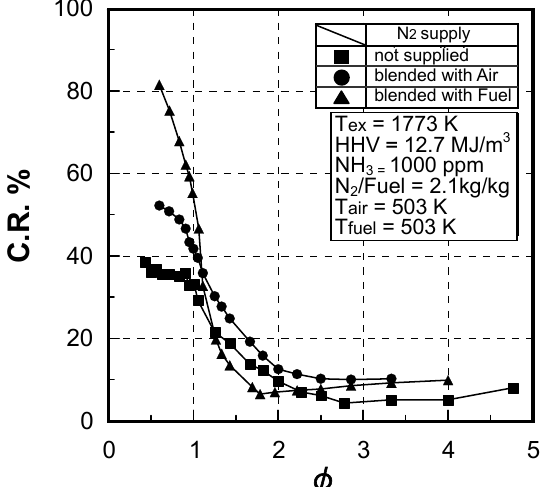
Figure 77. Effect of nitrogen injection on conversion rate of NH combustion, using small diffusion